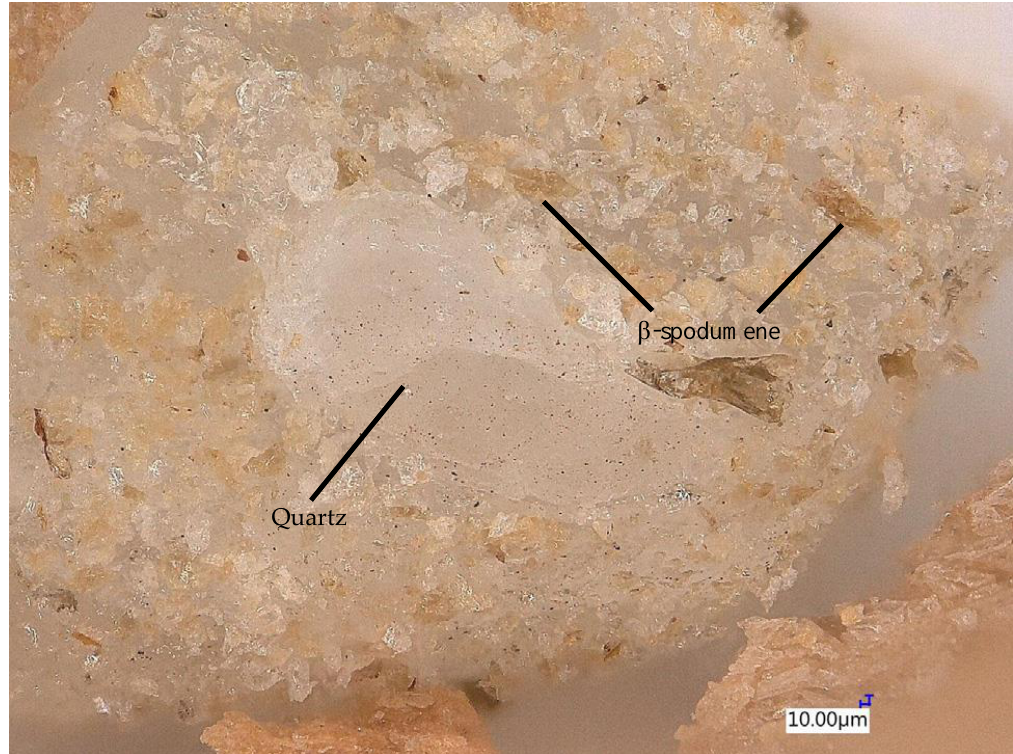
Figure 13 . β-spodumene particles included within a quartz matrix. The big white and translucent particle is quartz and the smaller orange particles contained inside are mostly spodumene [77] (reproduced with permission from Elsevier, Minerals Engineering; published by Elsevier, 2019) .